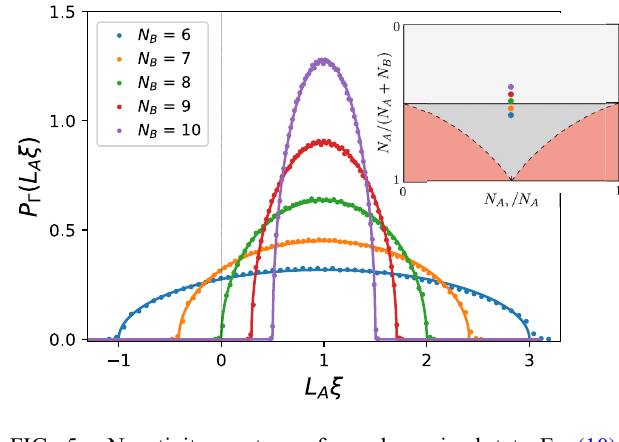
FIG. 5. Negativity spectrum of a random mixed state, Eq. (10), in the entanglement saturation regime (cf. region III in Fig. 2). Circles are numerical simulation and solid lines are semi- circle law, Eq. (77). Inset shows the location of each curve (color coded) in the phase diagram. Here, we choose N A = 3. Ensemble averages are performed over 10 4 N A 2